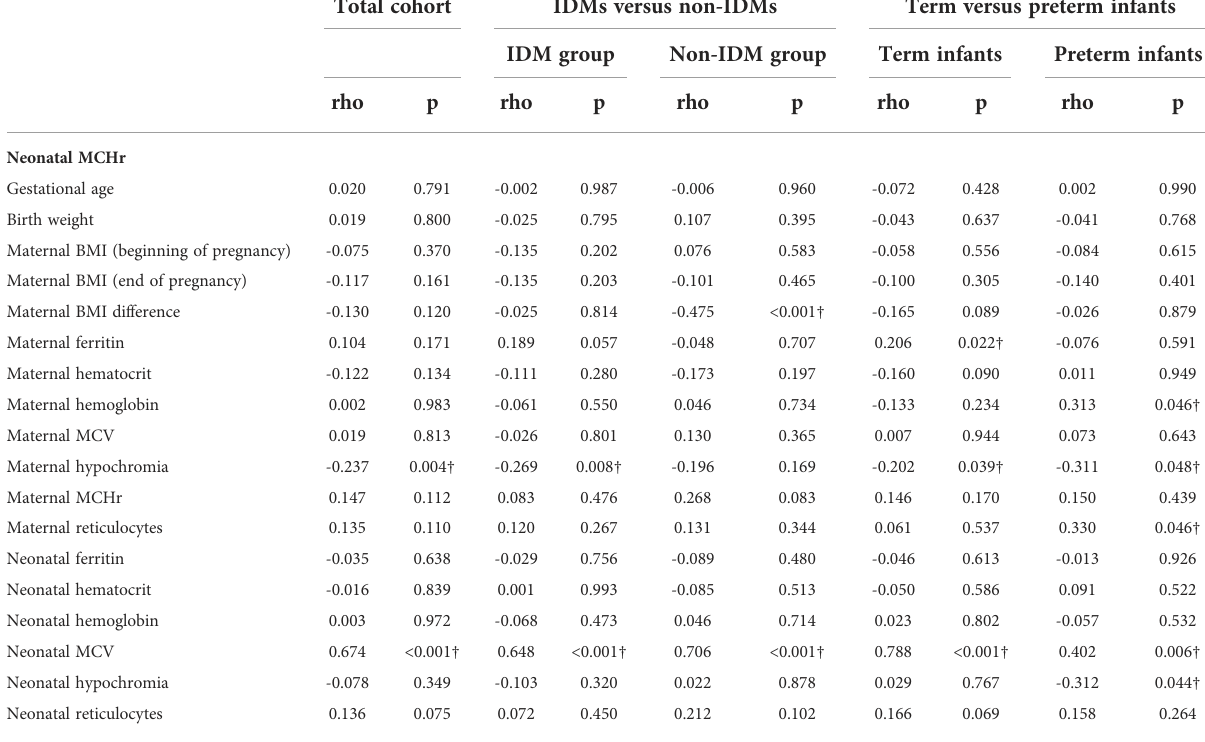
TABLE 2 Correlation between neonatal MCHr and continuous variables of interest in the total cohort, in IDM in comparison to non-IDM infants, and in term in comparison to preterm